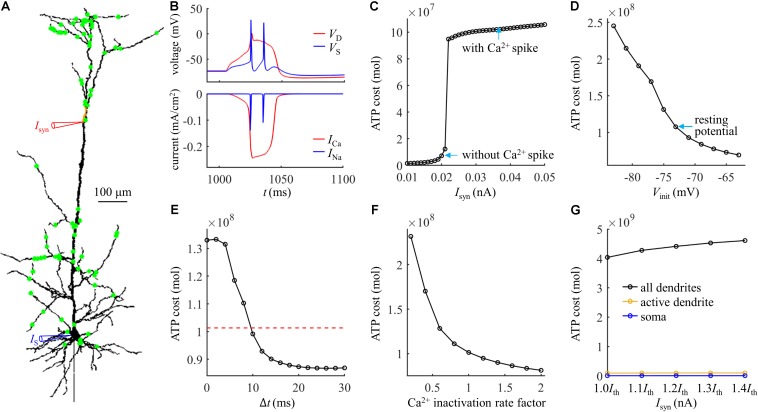
(A) Distribution of 100 excitatory inputs (green dots) over the dendrites. Each input Isyn was modeled with a double exponential function f(t) = e−t/τ1(1−e−t/τ2). Time constant was τ1 = 4 ms and τ2 = 0.8 ms. (B) Top panel: time courses of somatic voltage VS and dendritic voltage VD. Bottom panel: time courses of underlying INa and ICa (Isyn = Ith and IS = 0 nA). The threshold Ith for activation of a Ca2+ spike was 0.022 nA. VD and ICa were recorded in the active dendrite, which was indicated by a red triangle in (A). VS and INa were recorded in the soma, which was indicated by a blue triangle in (A). (C) ATP cost of a Ca2+ spike plotted as a function of Isyn (IS = 0 nA). (D) ATP cost of a Ca2+ spike plotted as a function of dendritic voltage. A constant current of 1000 ms was injected to the active dendrite. At the end of 1000 ms constant injection, 100 synaptic inputs were applied to evoke a Ca2+ AP. Vinit indicated the voltage at which a Ca2+ spike was initiated. Isyn = 2.3Ith and IS = 0 nA. (E) ATP cost of a Ca2+ spike plotted as a function of the Δt. Here Δt was defined as the interval between the onset of 100 inputs and somatic injection. The red dotted line indicated the ATP cost in the active dendrite without a bAP. Isyn = 1.5Ith and IS = 1.9 nA. (F) ATP cost of a Ca2+ spike plotted as a function of Ca2+ inactivation rate factor. Isyn = 1.5Ith and IS = 0 nA. (G) ATP cost in the dendrites and soma during a Ca2+ spike. Isyn = 1.0Ith, 1.1Ith, 1.2Ith, 1.3Ith, and 1.4Ith. In (C–F), the ATP cost on Ca2+ extrusion was computed in the active dendrite. In (G), the ATP consumption on Ca2+ extrusion was computed in the active dendrite and whole dendrites, and the consumption on Na+ extrusion was computed in the soma.